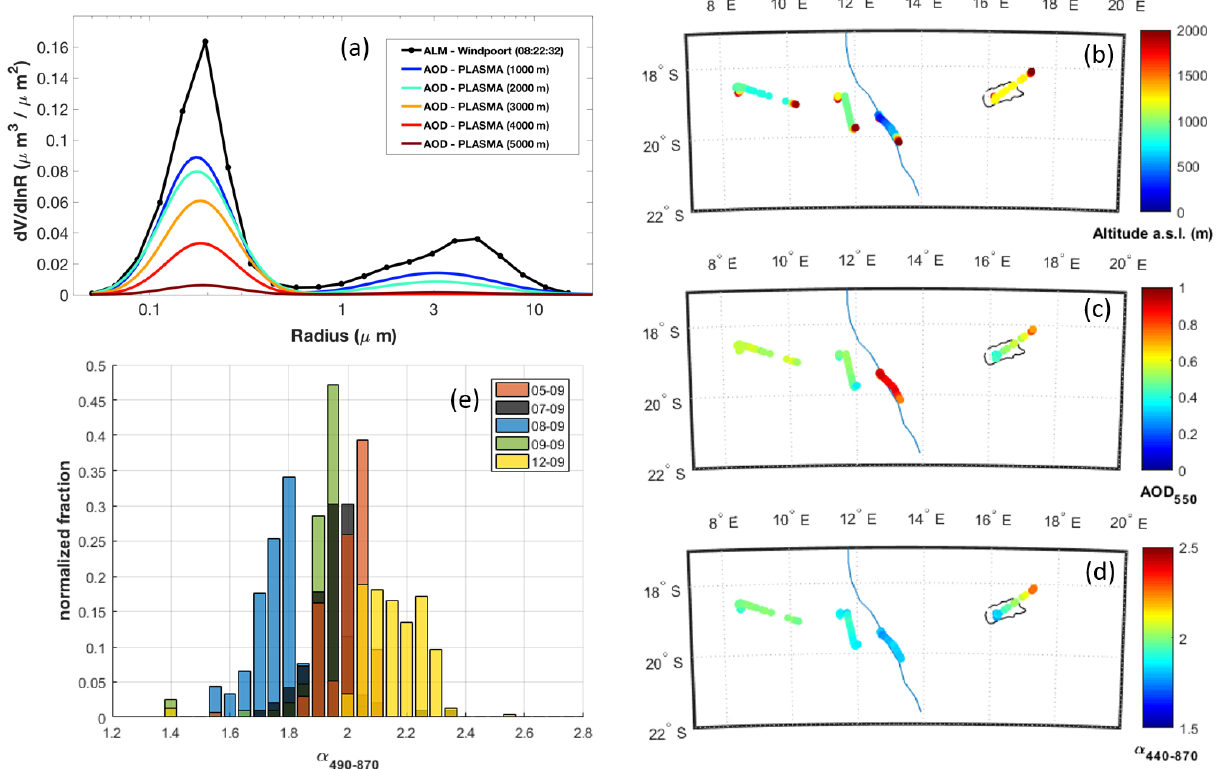
Figure 8. (a) Retrieved volume particle size distributions at different altitudes from PLASMA2 measurements and from the AERONET station at Windpoort, Namibia, for the descent in the loop on 7 September 2017. Flight altitude (b) , AOD (c) , and Ångström exponent (d) measured by PLASMA2 during AEROCLO-sA. The black line corresponds to the Etosha Pan. Only low-altitude flights are presented. (e) Extinction Ångström exponent from OSIRIS measurements histograms for the five selected flights.